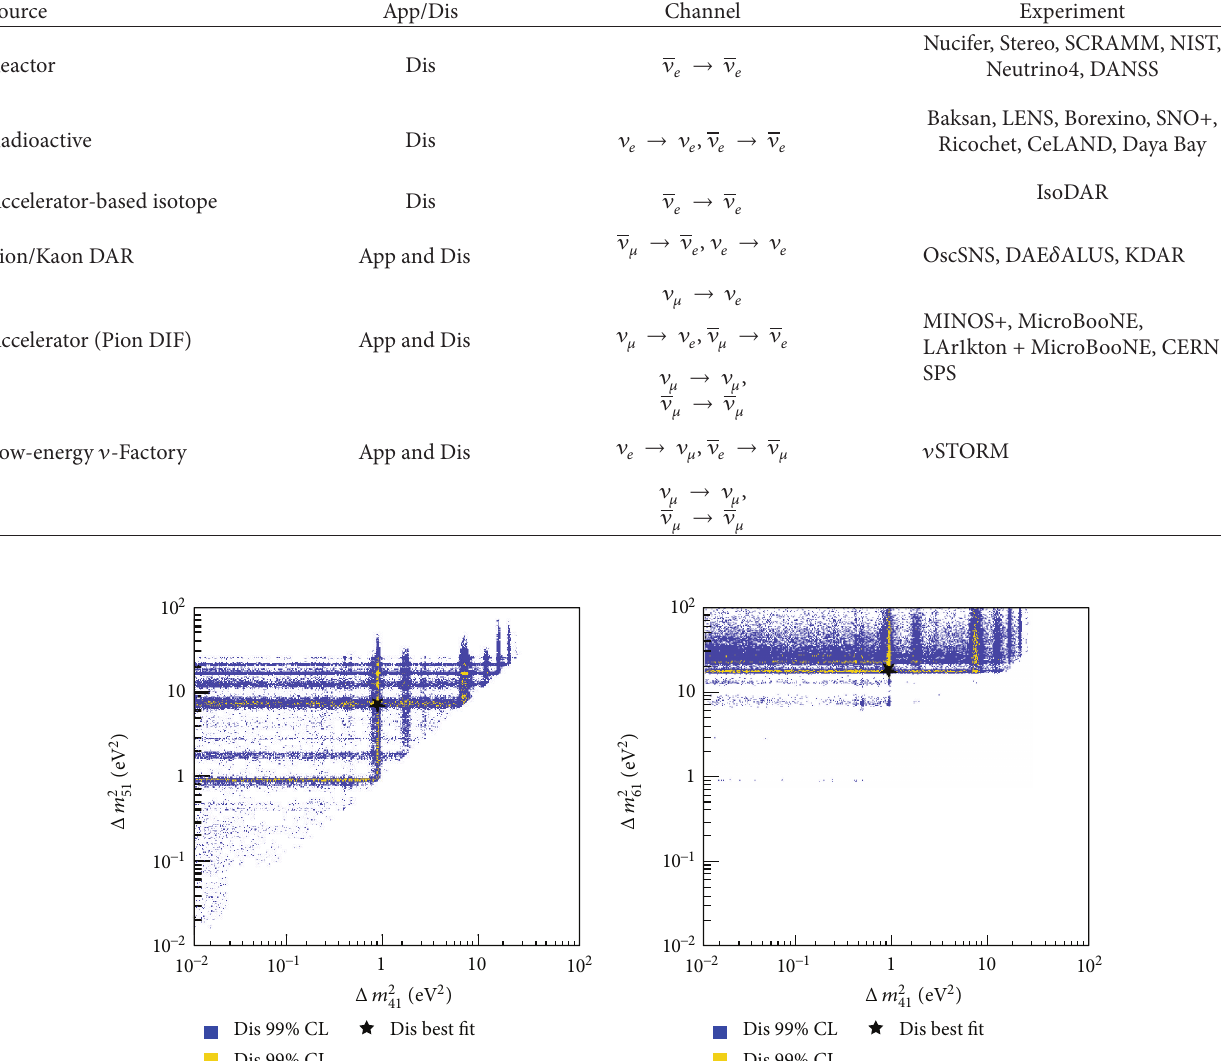
Table 4: A summary of current and future sterile neutrino oscillation experiments.